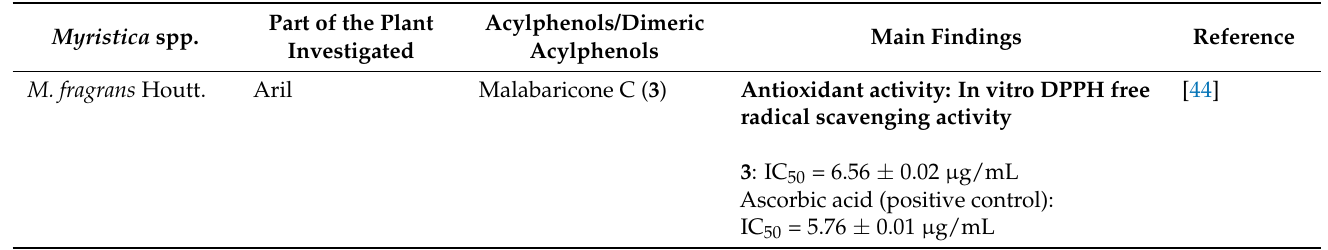
Table 3. The antioxidant activities of acylphenols and dimeric acylphenols from the genus Myristica . Myristica